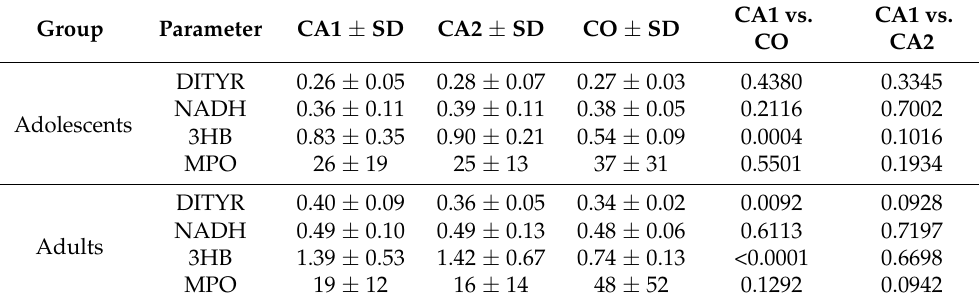
Table 2. Comparison of levels of measured parameters between case1, case2, and